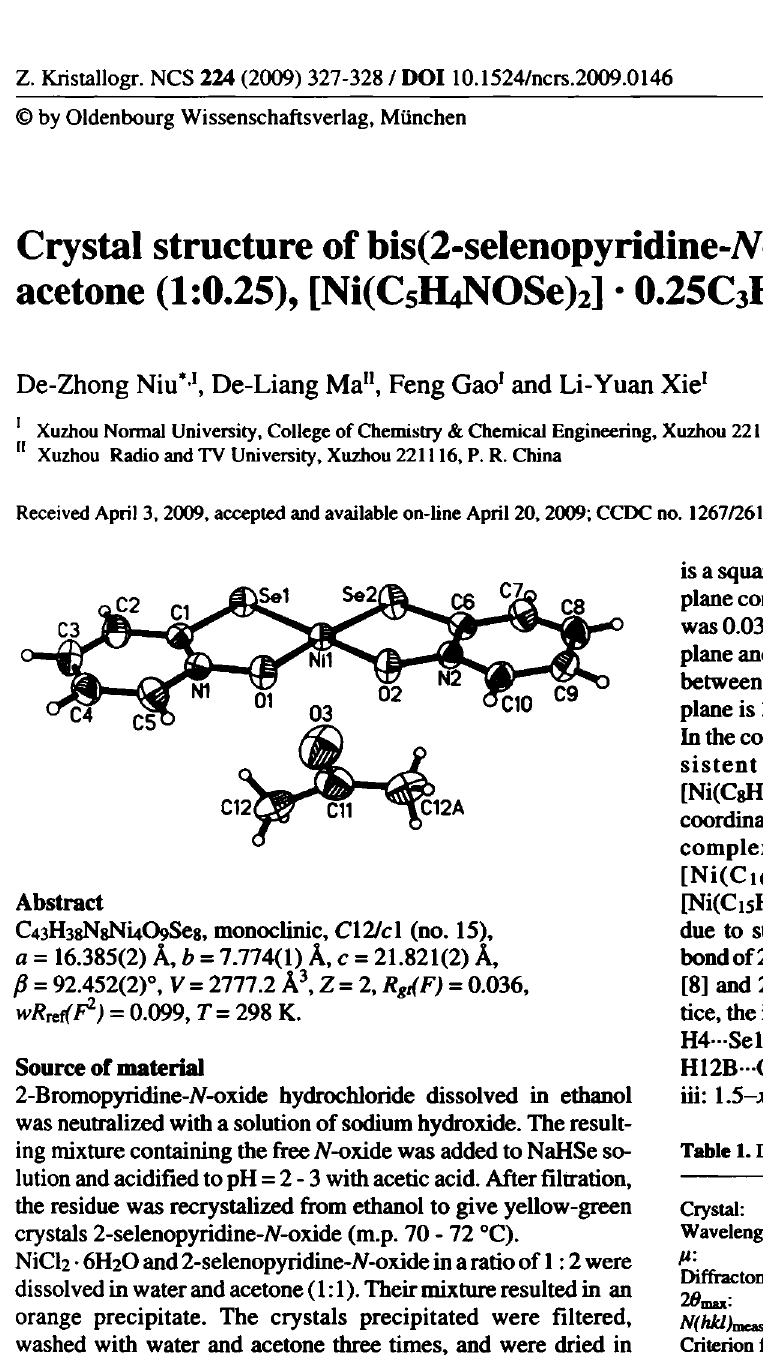
Table 2. Atomic coordinates and displacement parameters (in Â 2